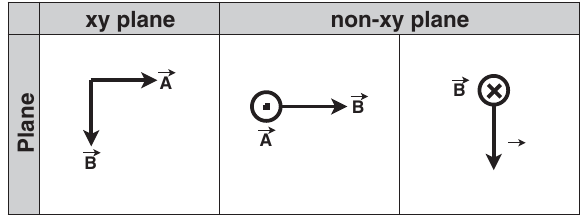
FIG. 5. Examples of physically awkward orientations in the xy and non- xy planes.